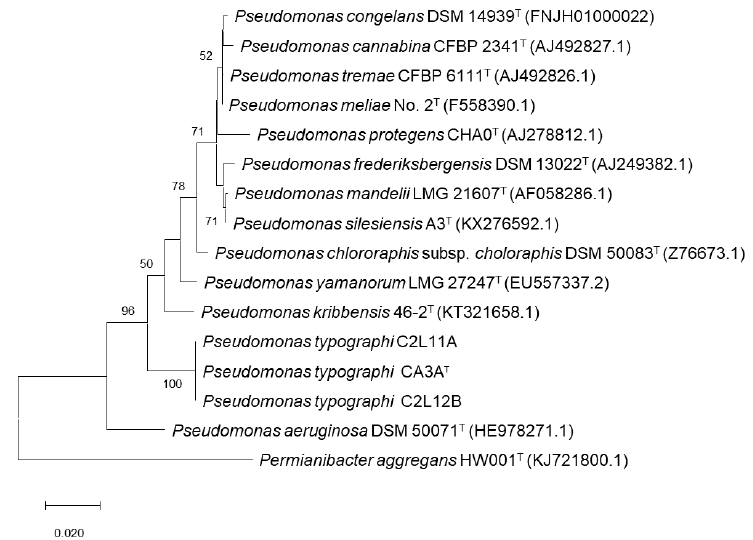
Figure 1. Maximum-likelihood phylogenetic tree based on complete 16S rRNA gene sequences of all Pseudomonas species closely related to P. typographi CA3A T , C2L11, and C2L12B, P. aeruginosa DSM50071 T , and P. aggregans HW001 T . Bootstrap values (expressed as percentages of 1000 replications) are shown at the branching points; values below 50 were discarded. Scale bar = 2 nucleotide (nt) substitutions per 100 nt. Accession numbers of the sequences are indicated in parentheses .